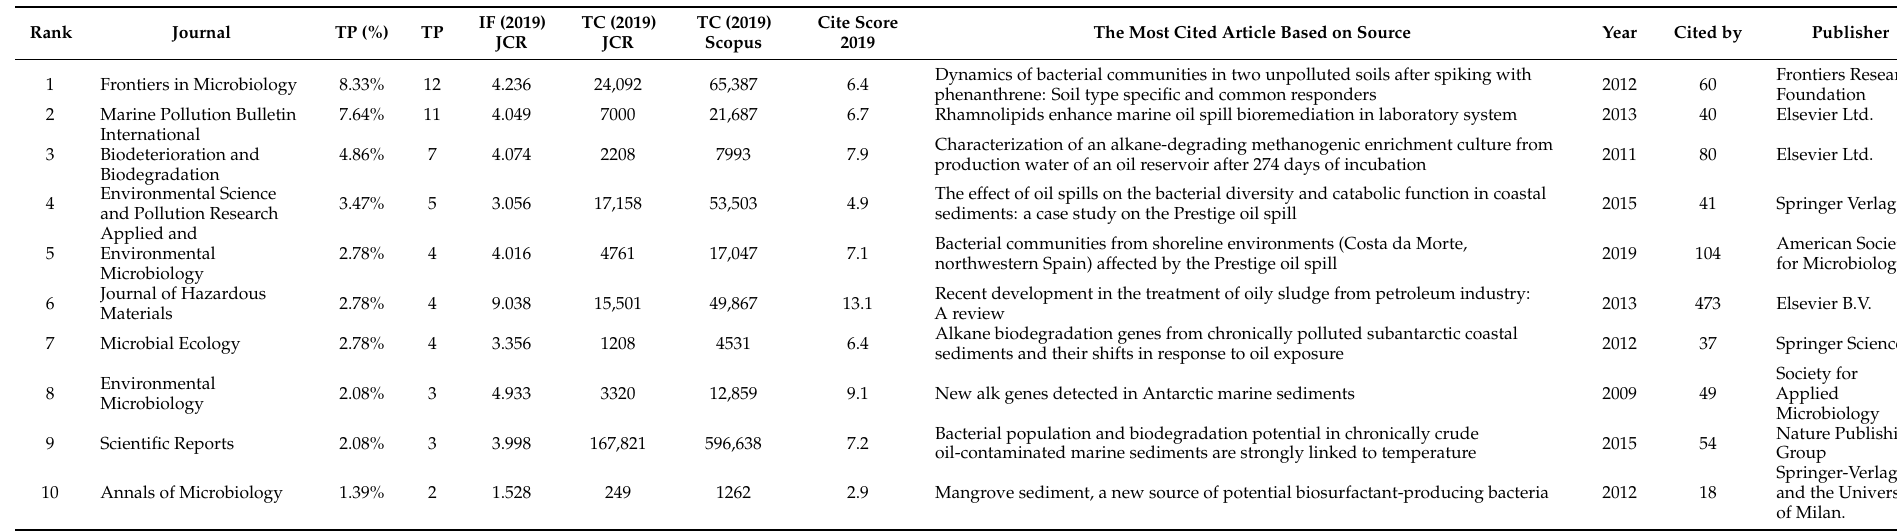
Table 3. Top ten most productive journals on degradation of hydrocarbons by Antarctic microbial community research with their most cited